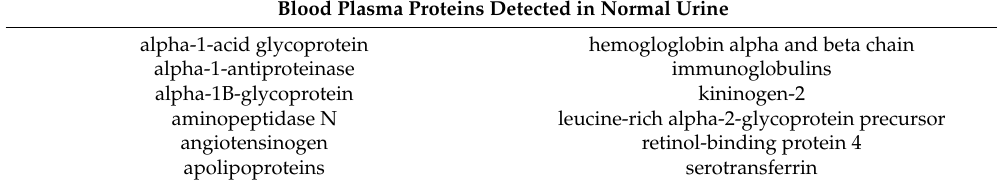
Table 1. Tissue origin of proteins identified in the urine of newborn calves (detailed list of proteins with their accession numbers is given in Supplementary Table S3). UniProt [19] was used to infer the molecular functions of the identified